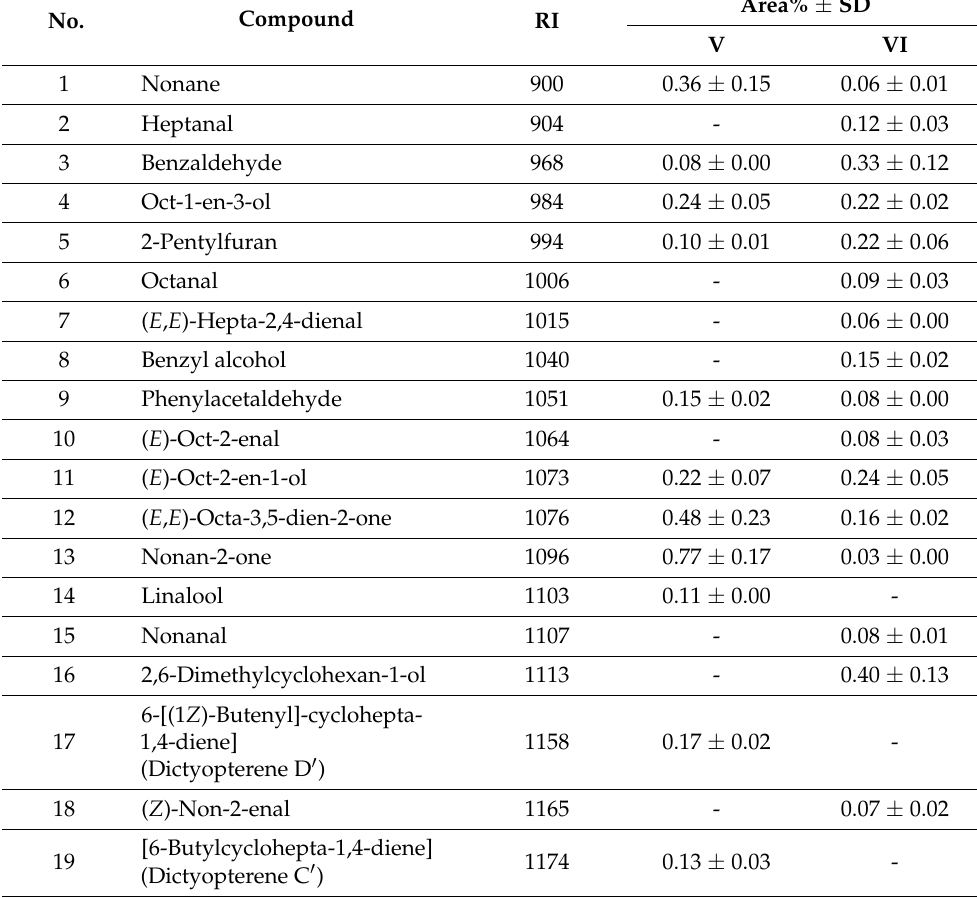
Table 2. The VOCs from D. vermicularis isolated by hydrodistillation (HD) and analysed by gas chromatography–mass spectrometry (GC–MS): (V—hydrodistillate of fresh D. vermicularis , VI—hydrodistillate of air-dried D. vermicularis